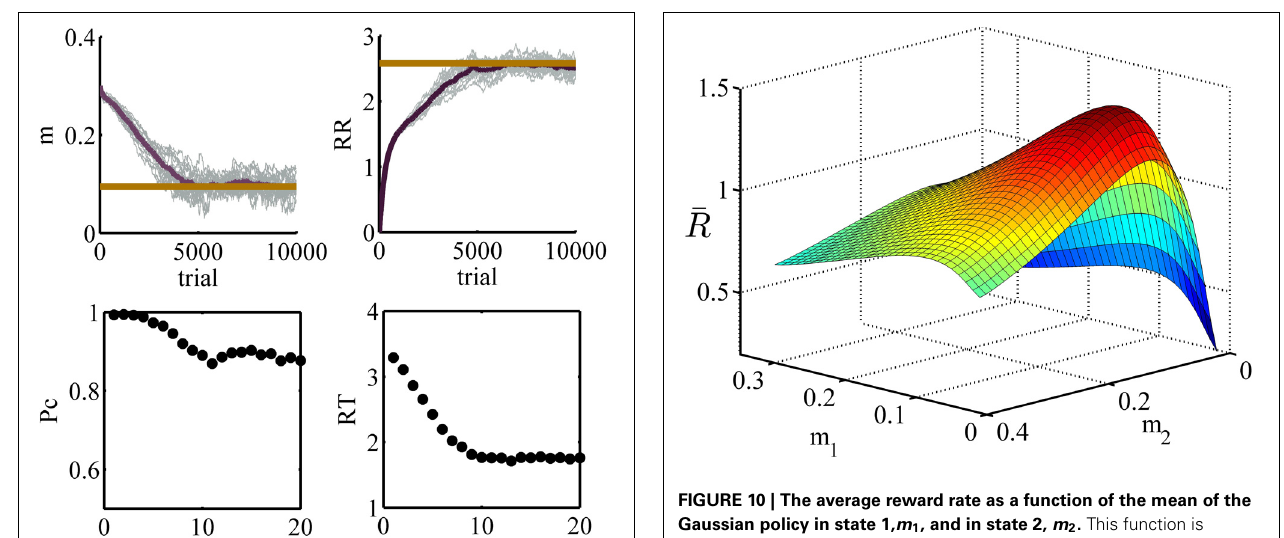
value of the parameter m as a function of trial and the right top